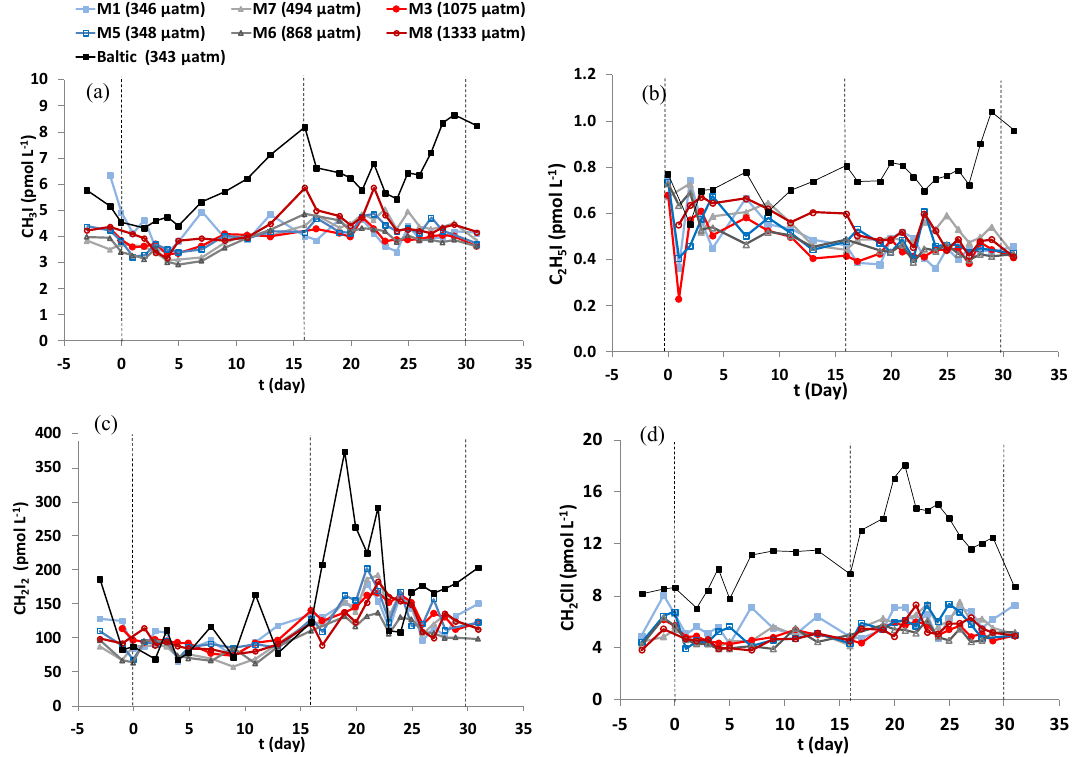
Figure 3. Mean concentrations (pmolL − 1 ) of (a) CH 3 I, (b) C 2 H 5 I, (c) CH 2 I 2 , and (d) CH 2 ClI taken from a water sample integrated from the surface 10m. Dashed lines indicate the phases of the experiment, as given in Fig. 2. f CO 2 shown in the legend is mean f CO 2 across the duration of the